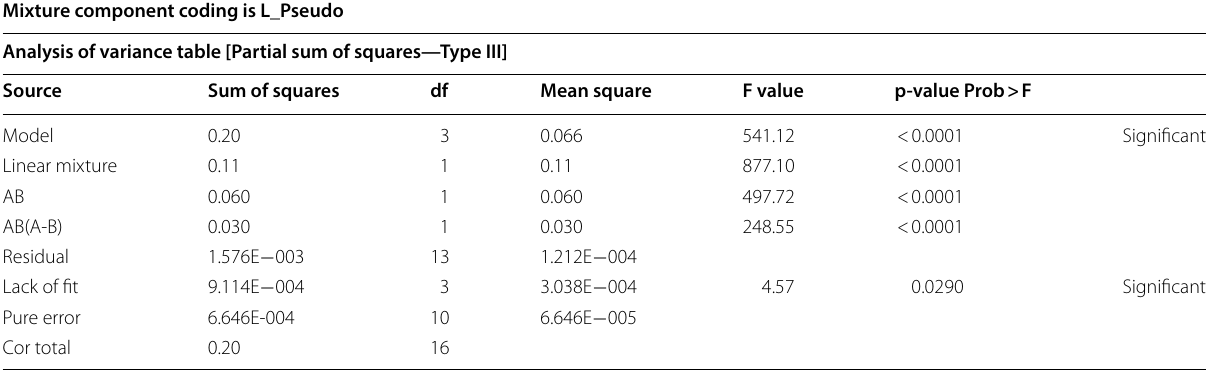
Table 5 ANOVA for linear mixture model for the response 3: cost Mixture component coding is L_Pseudo Analysis of variance table [Partial sum of squares—Type